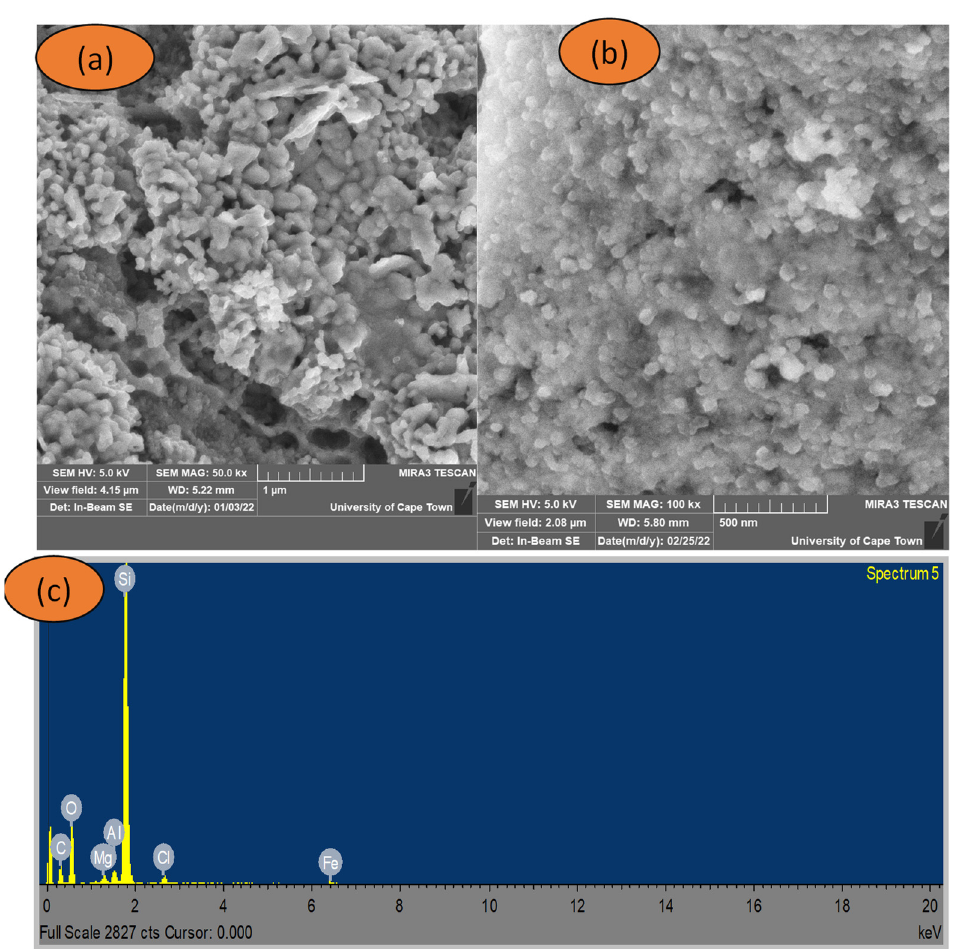
Figure 4. SEM images of ( a , b ) SCBA nano silicon and EDX spectrum ( c ) of SCBA nano silicon.